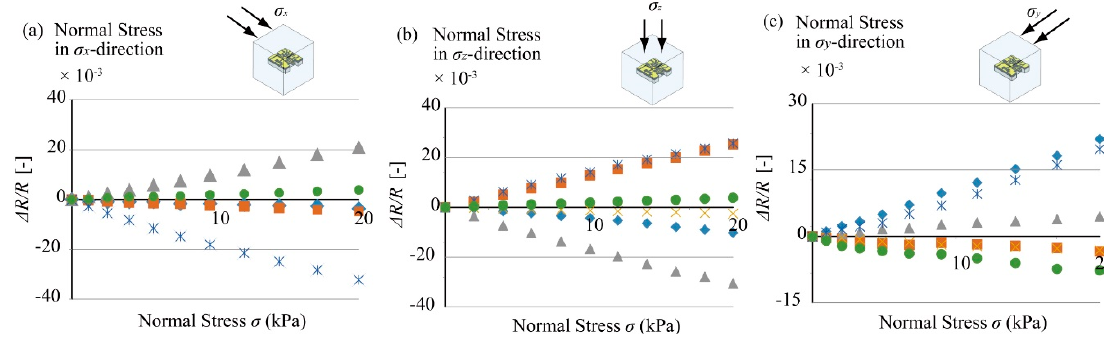
Figure 13. Sensor outputs under normal stresses; ( a ) responses to τ zx , ( b ) responses to τ zy , and ( c ) responses to τ xy.